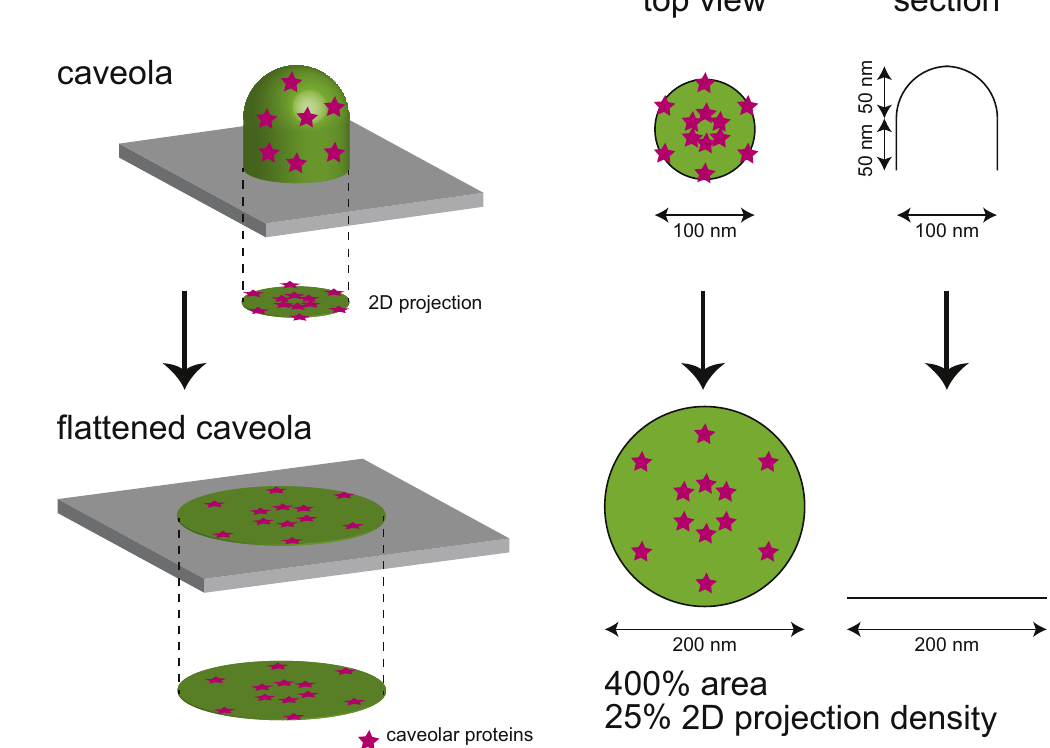
Figure 1. The expected density of caveolin-1 in a two-dimensional projection of a flattened caveola. A caveola typically has a 100 nm diameter and a 100 nm depth. We approximated a caveola as a cylinder with a 50 nm depth and a 100 nm diameter, capped with a 100 nm diameter hemisphere. The entire area of this structure is unfolded into a flat membrane and the two-dimensional, projected area is calculated to be increased 4-fold. Therefore, the density of molecules associated with the two-dimensionally projected caveola, such as caveolin-1, is expected to be decreased to 25% of the density of molecules associated with the folded